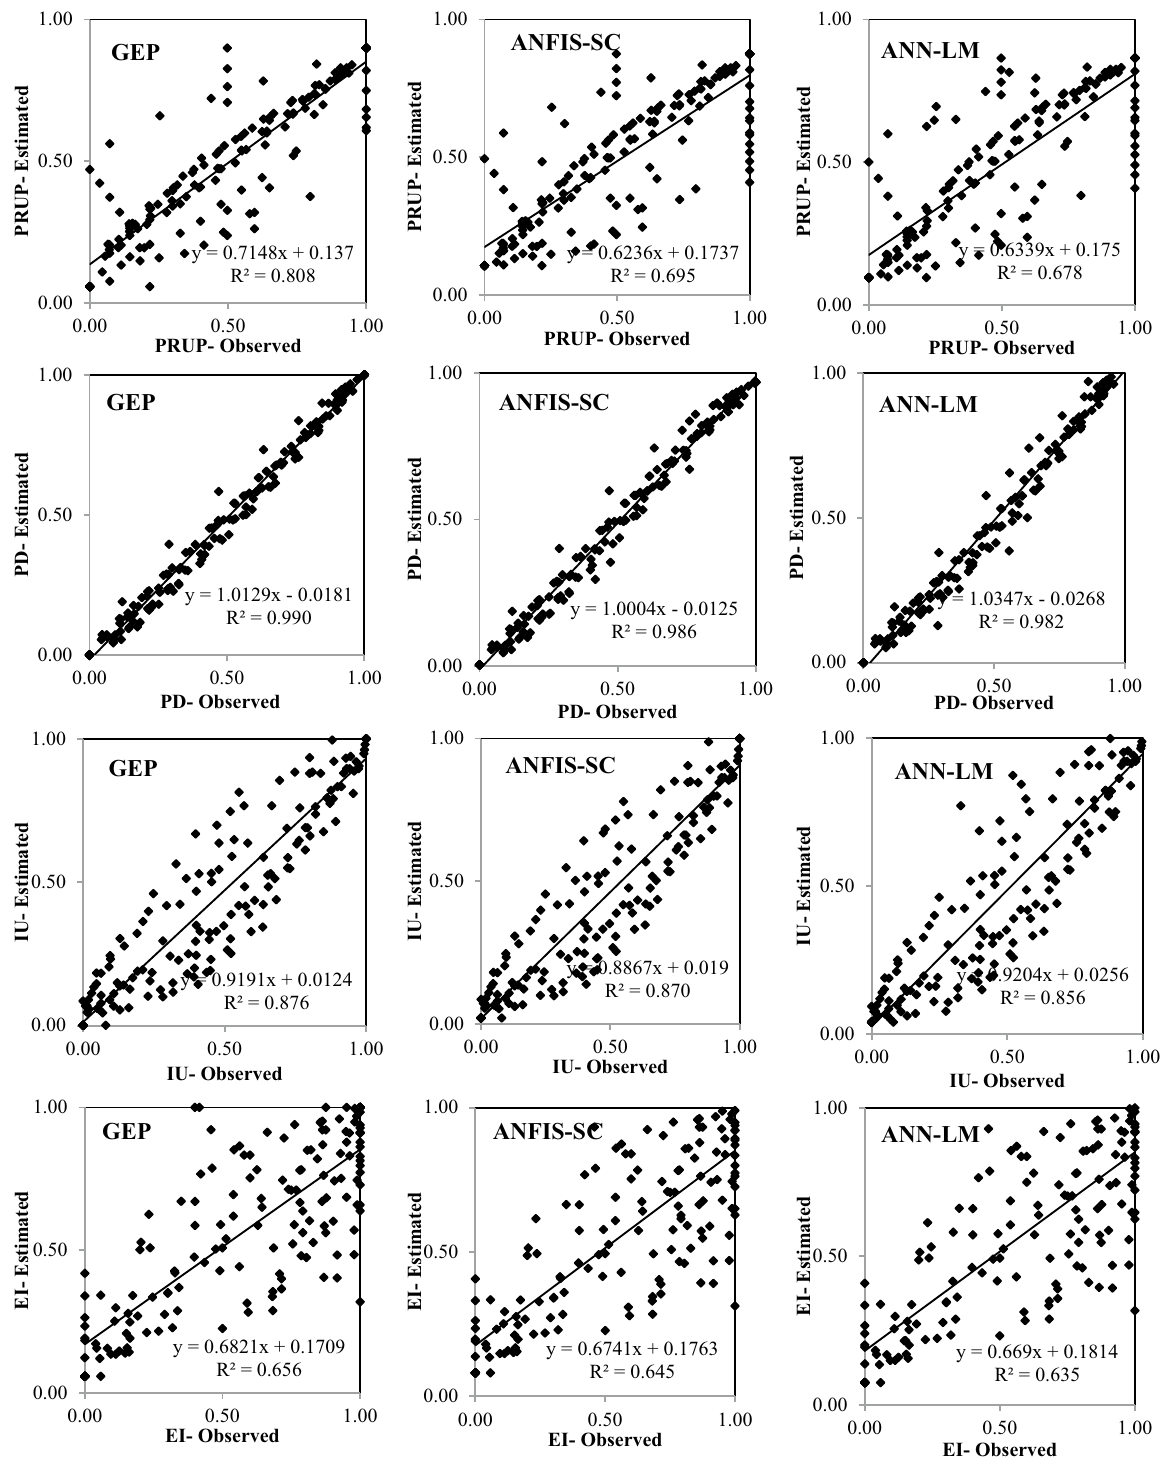
Figure 8. Observed and estimated social parameters during the testing period in